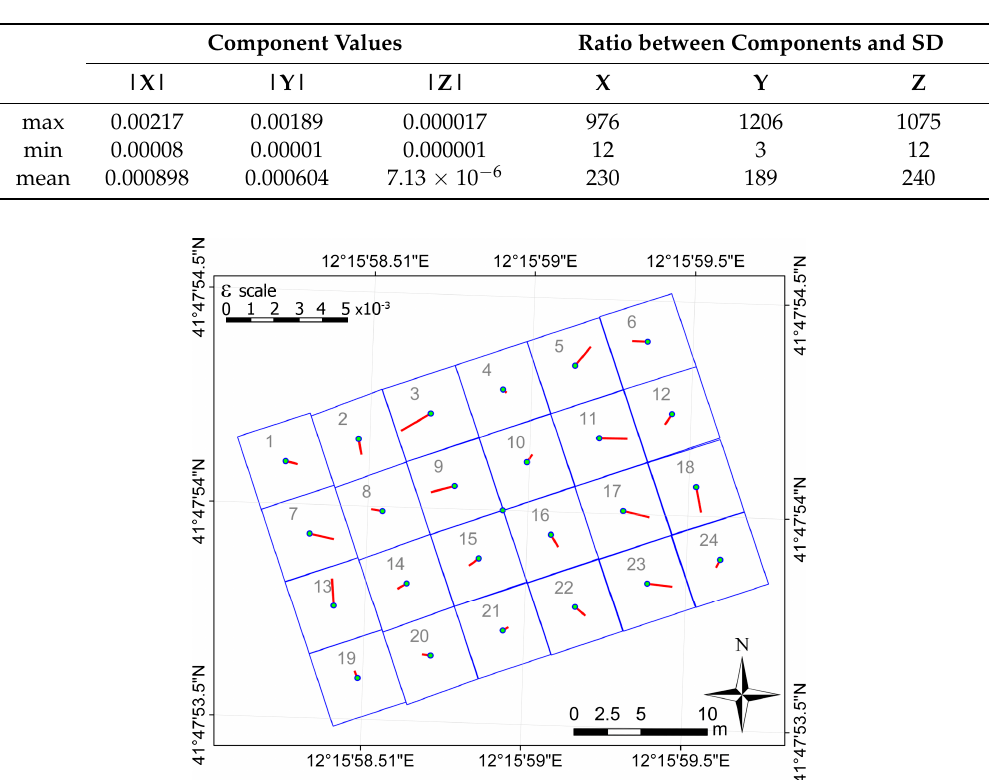
Figure 7. Magnitude and directions of the projection of the vector ɛ differences between the perpendiculars to the single slab and the general plane onto the general plane.